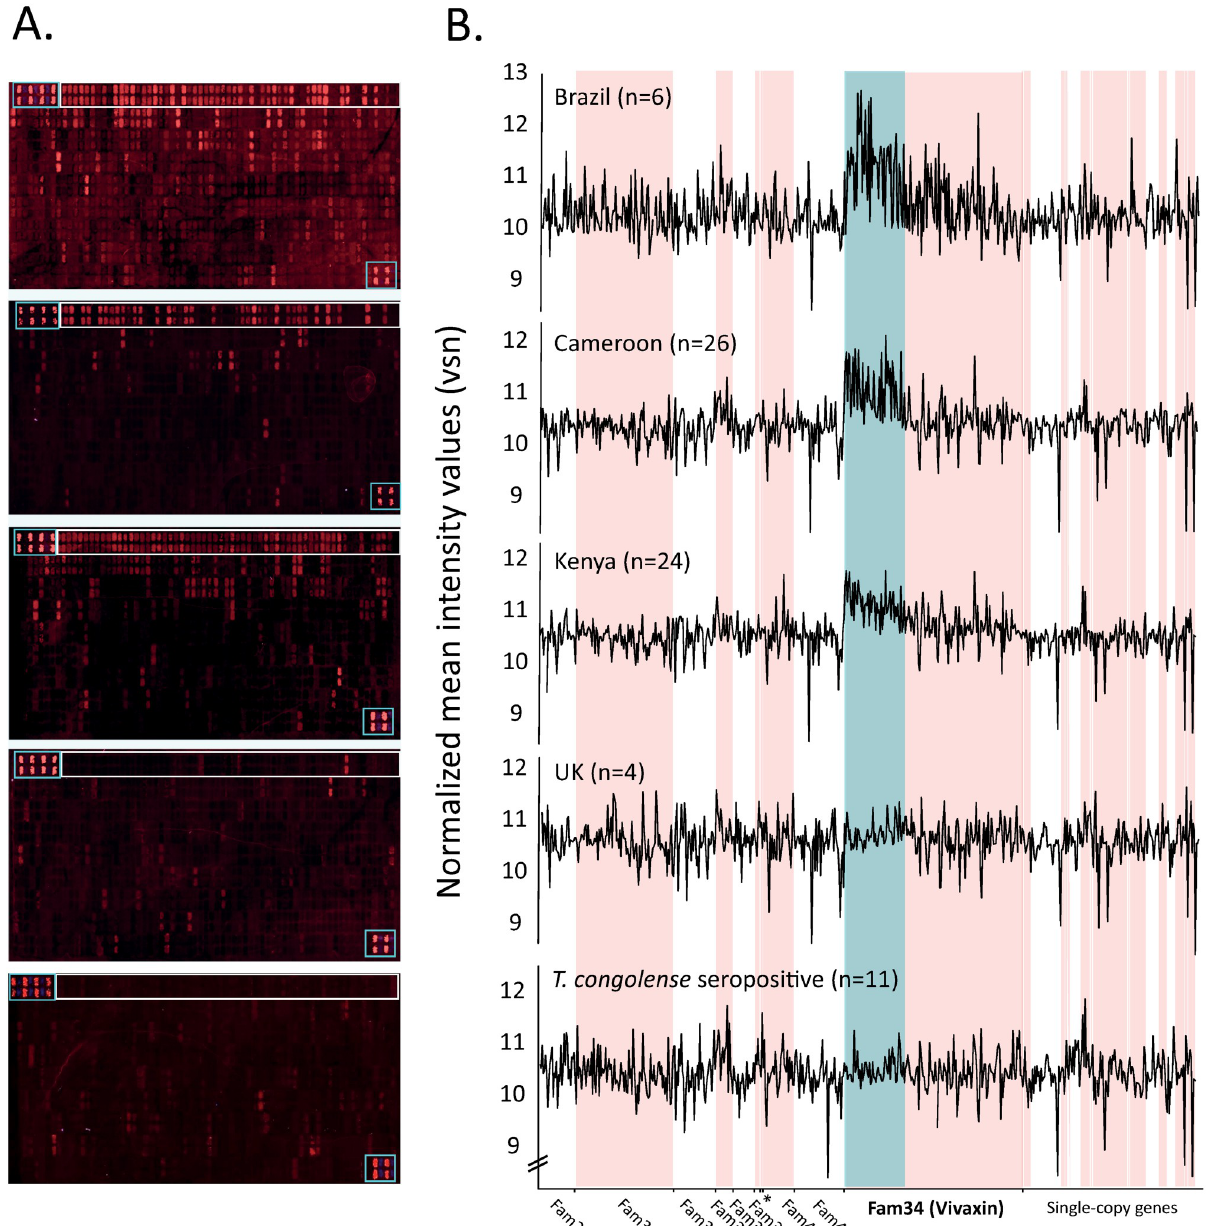
Fig 1. Immuno-profiling of host serum with a Trypanosoma vivax -specific antigen array. (A) Fluorescence observed after application of host sera to a customised array of 600 peptides representing 63 T . vivax -specific antigens. From top to bottom, the panels show responses to serum from three locations (Brazil, Cameroon and Kenya respectively), in addition to two negative controls (serum from UK cattle and from Cameroonian cattle that tested T . vivax -negative but T . congolense -positive). Control peptides are shown in boxes at top left and bottom right of each array. The top row of the array (boxed) contains peptides exclusively derived from vivaxin proteins. (B) Normalized intensity values of immuno-fluorescent responses in (A) are plotted for all array peptides, arranged by gene family. Individual gene families are indicated by alternating white and pink shading. Strongly- responding peptides belonging to vivaxin (Fam34) are indicated by blue